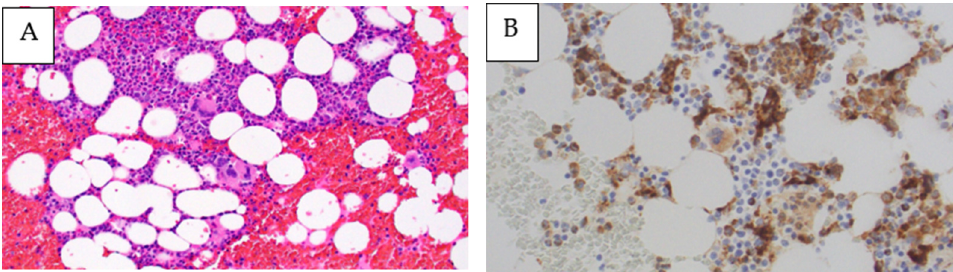
Figure 2. Bone marrow biopsy collected on day 7 of admission. ( A ) Hematoxylin and eosin staining indicating a normocellular bone marrow. No increase in megakaryocytes or reticulin fibers. Plasma cells and eosinophils are hyperplastic. Megakaryocytes with hypersegmented nuclear atypia are present Magnification ×400; ( B ) CD68 staining depicts an increased number of histiocytes. Magnification ×400. Table 1. Blood laboratory findings on day 6 of